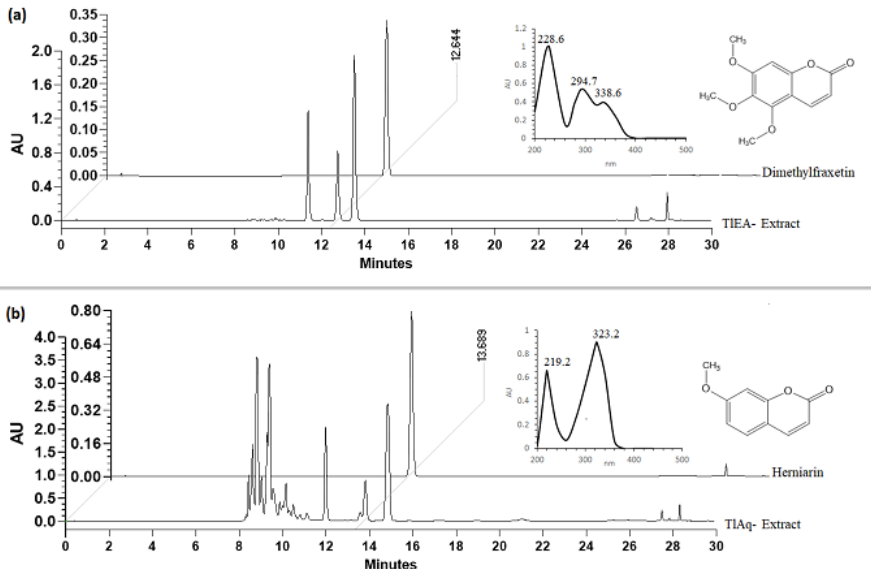
Figure 1. HPLC chromatograms show the chemical profile. AU, absorbance units; ( a ) RT of the TlEA, UV spectrum, and chemical structure of dimethylfraxetin (DF); ( b ) RT of the TlEA, UV spectrum, and chemical structure of herniarin (HN).